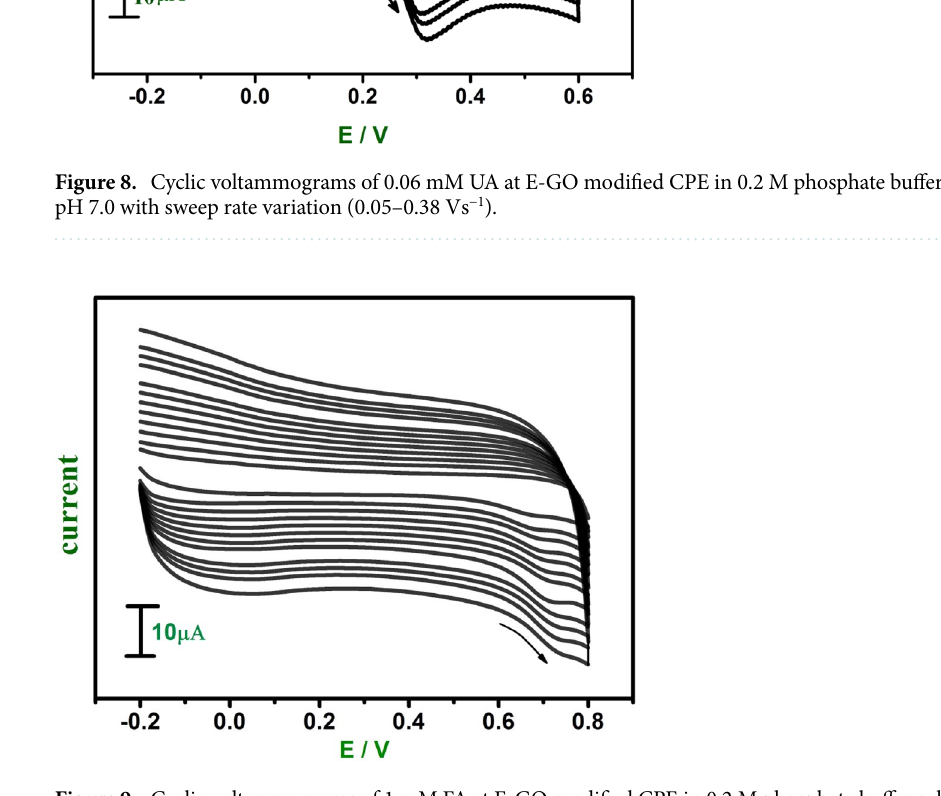
Figure 9. Cyclic voltammograms of 1 mM FA at E-GO modified CPE in 0.2 M phosphate buffer solution at pH 7.0 with sweep rate variation (0.05–0.38 Vs −1